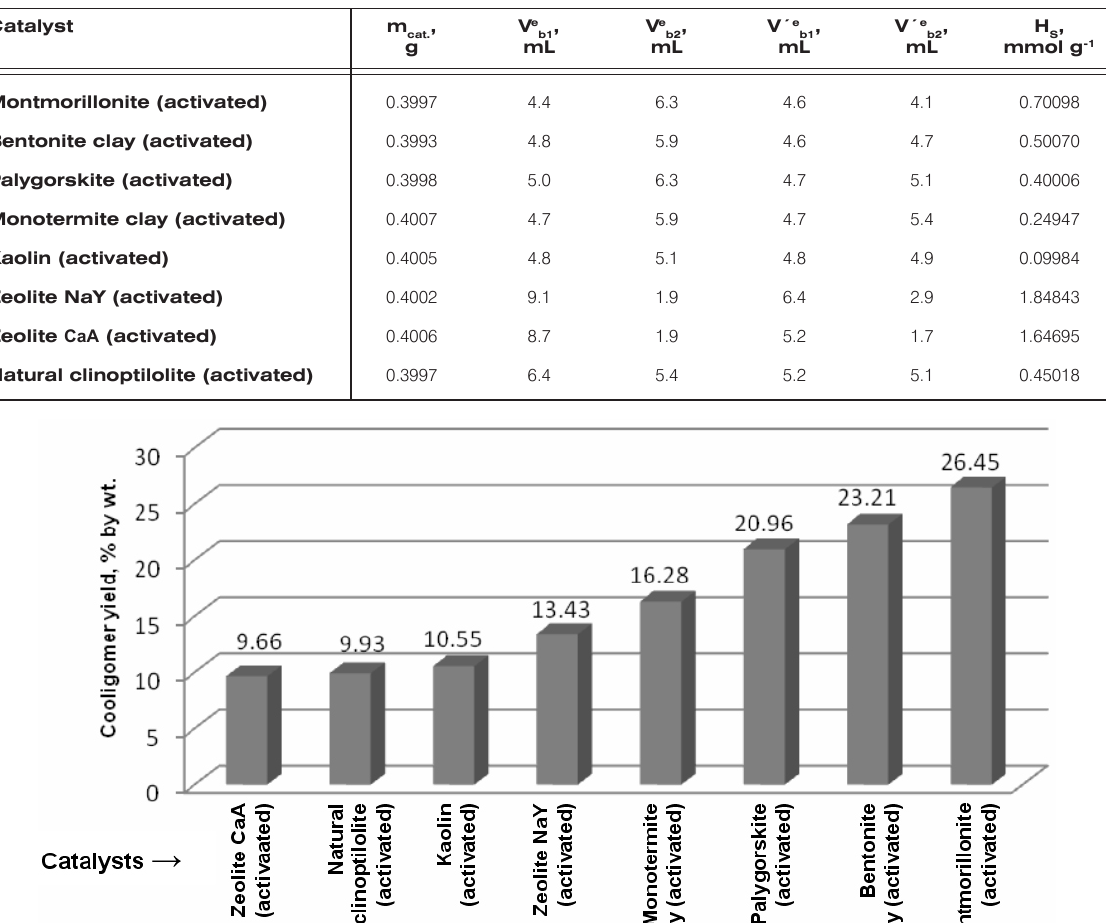
Table 1. Determination of active sites concentration of activated silica-alumina catalysts. Catalyst